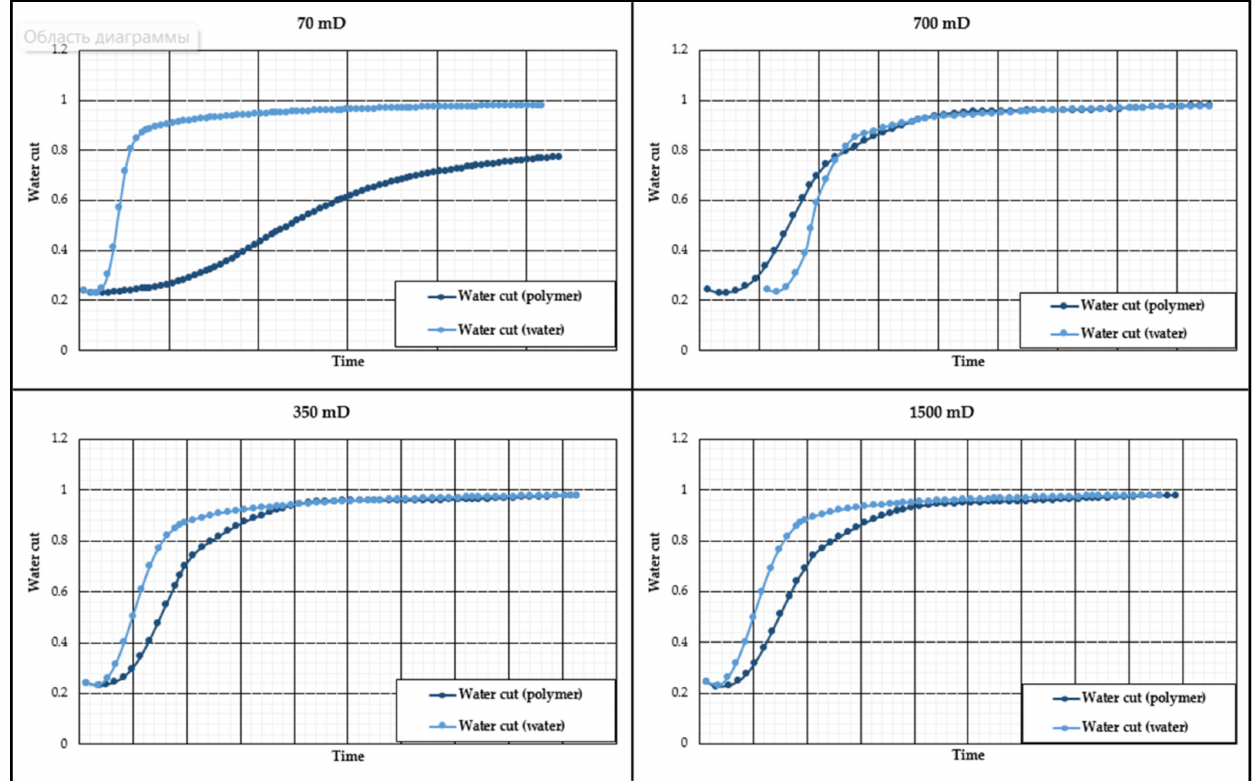
Figure 14. Water cut dynamics for different permeability models. Below is the distribution of residual oil saturation at the end of the calculation period 70-mD reservoir model, which were assessed as well.